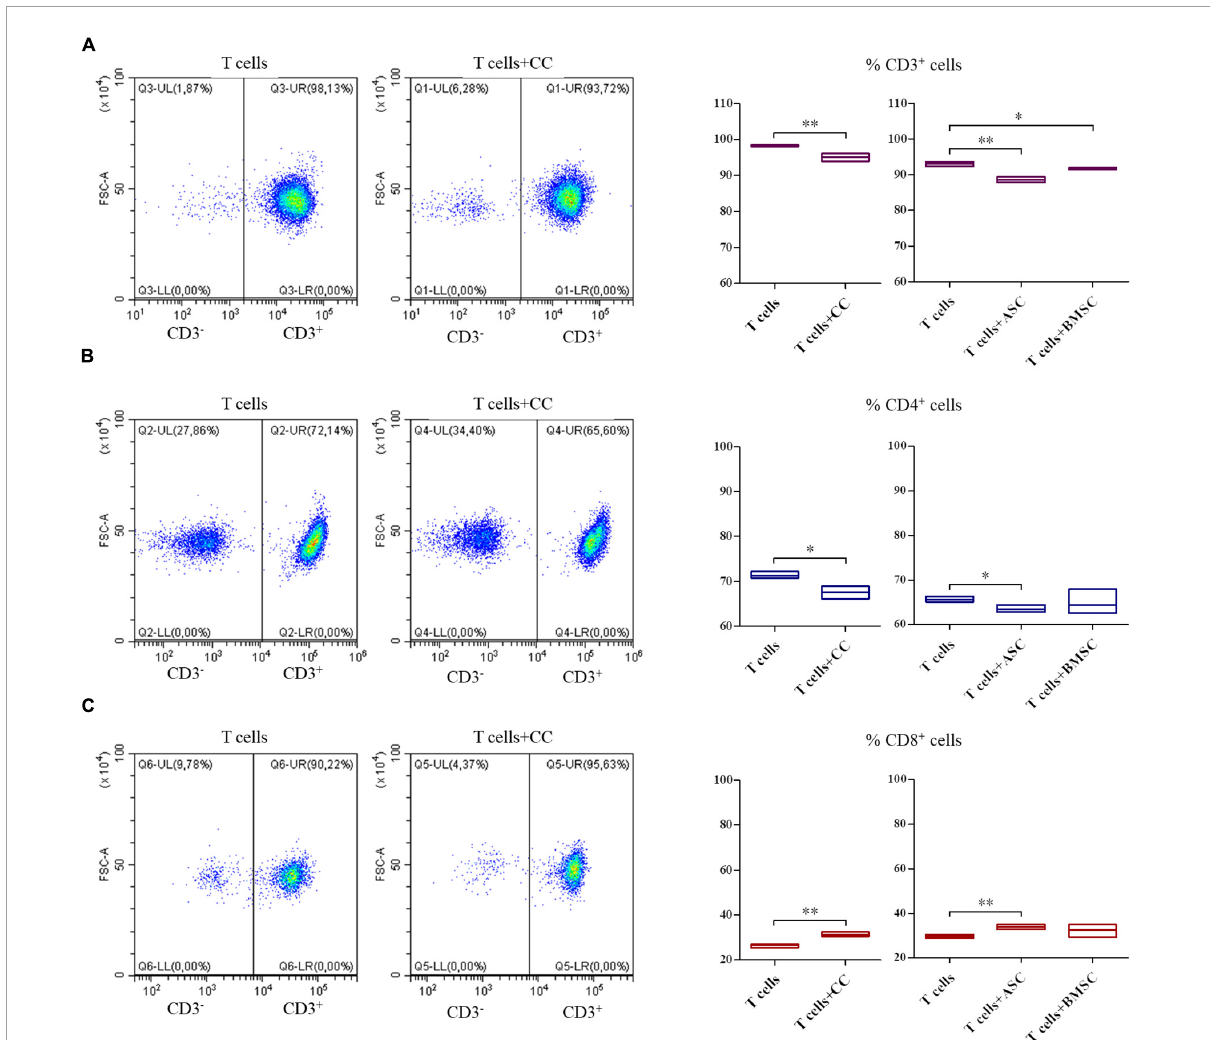
FIGURE5 Modulation of T cell survival and phenotype by cartilage cells (CCs), adipose tissue-derived (ASCs), and bone marrow-derived stem cells (BMSCs). For CD3 + (A) , CD4 + (B) , and CD8 + (C) cell representative density plots show T cells co-cultured with CCs. Floating bars represent mean to max percentages and mean values of cells positive for the different analyzed markers in T cells and co-cultured T cells with CCs, ASCs, and BMSCs. N = 3; ∗ p < 0.05, ∗∗ p < 0.001.